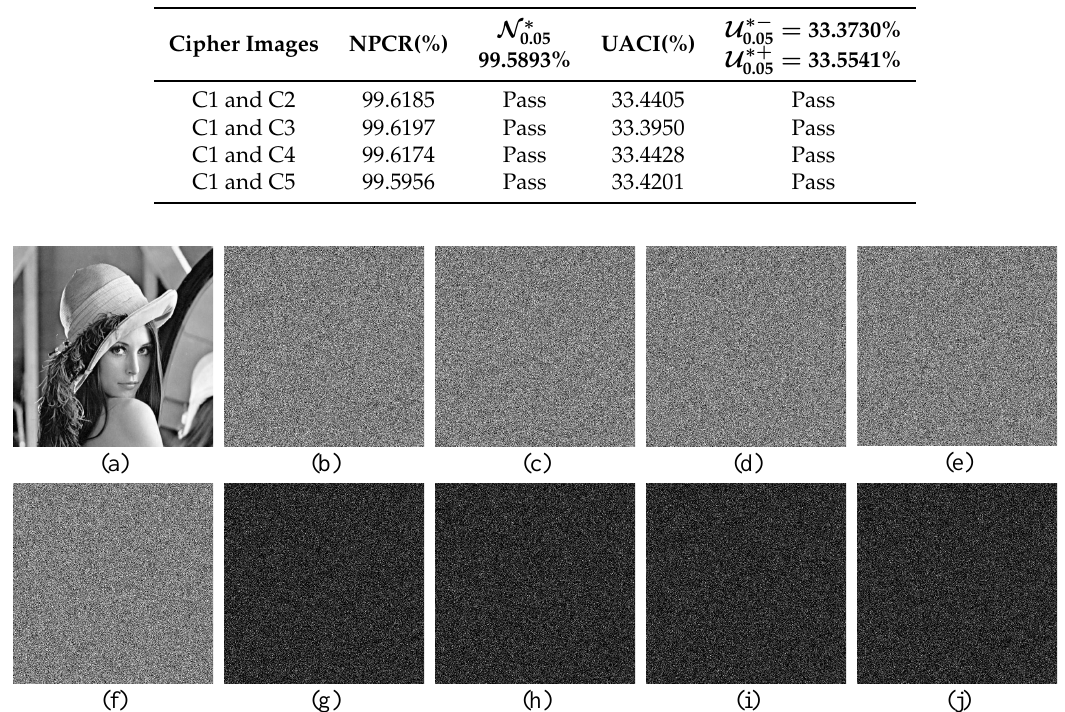
Table 8. Quantitative analysis of key sensitivity.